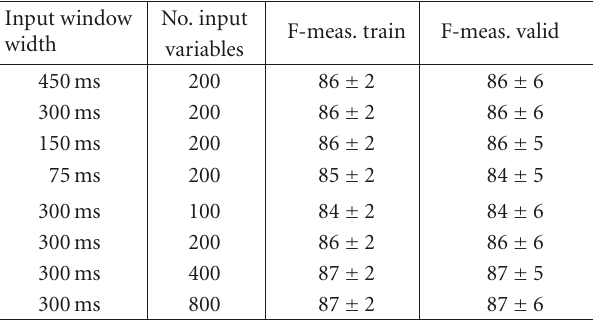
Table 2: Results for testing di ff erent input window sizes and di ff er- ent numbers of input variables. Above the number of input vari- ables is held constant at 200. Below the input window width is held constant at 300 milliseconds. It is shown that the input win- dow width is not crucial provided that it is large enough. However, the number of input variables is important.